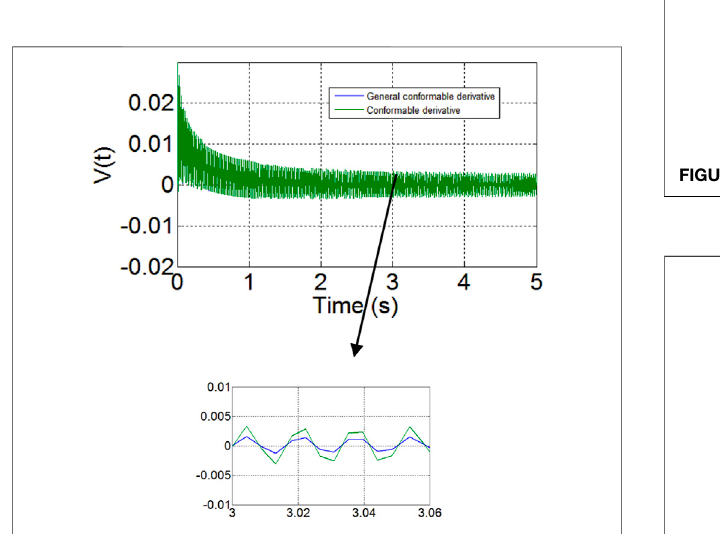
FIGURE 5 | Evolution of V ( t ) with α (cid:2) 0 . 7.